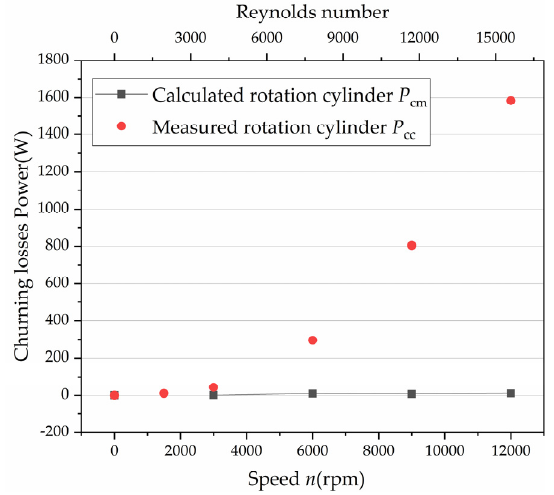
Figure 4. Churning losses: comparisons between the calculated and the experimental results. The parameters affecting the churning losses were classified according to the type of influence and are described in Figure 5: the pump geometry was described by the radius of the cylinder block R c , length of the cylinder block l c and the gap between the cylinder block and the housing internal surface t ; the characteristics of the lubricant were described by the viscosity μ and density ρ ; the working conditions were described by the rotational speed ω .